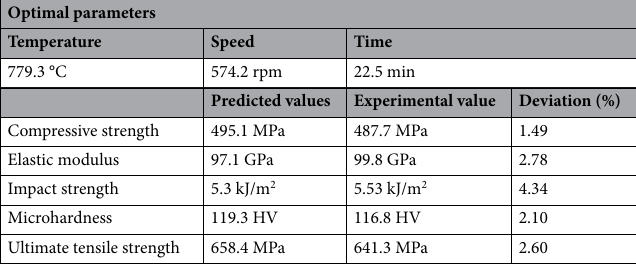
Table 11. Optimal parameters and validation result. Composite desirability = 0.94.